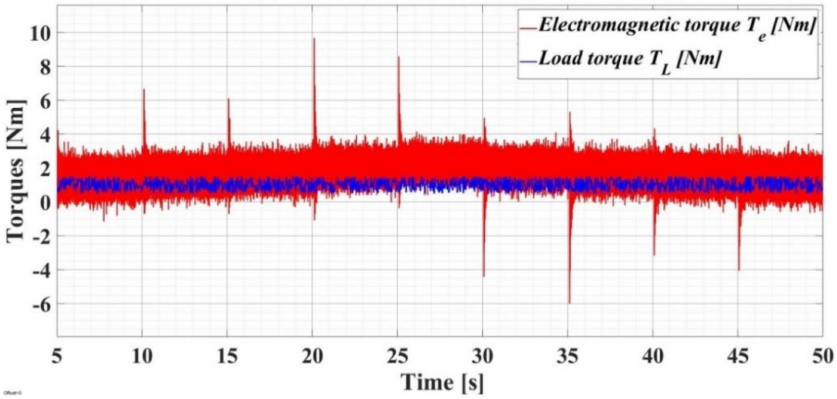
Figure 28. Real-time evolution of torques T e and T L for PMSM–CS–CI based on the LQR-type controller.